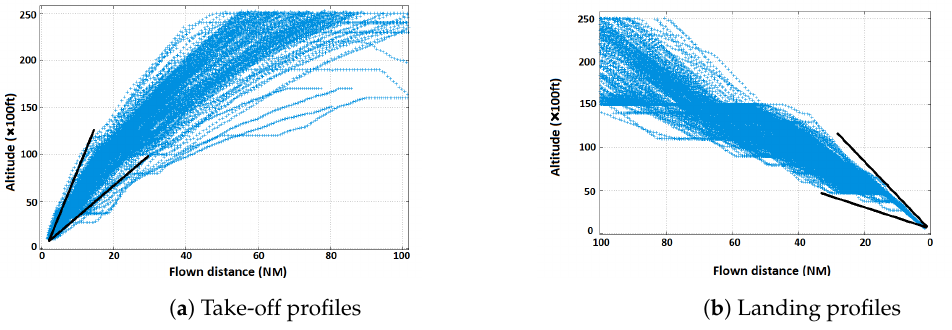
Figure 2. Take-off and landing profiles in Paris CDG airport